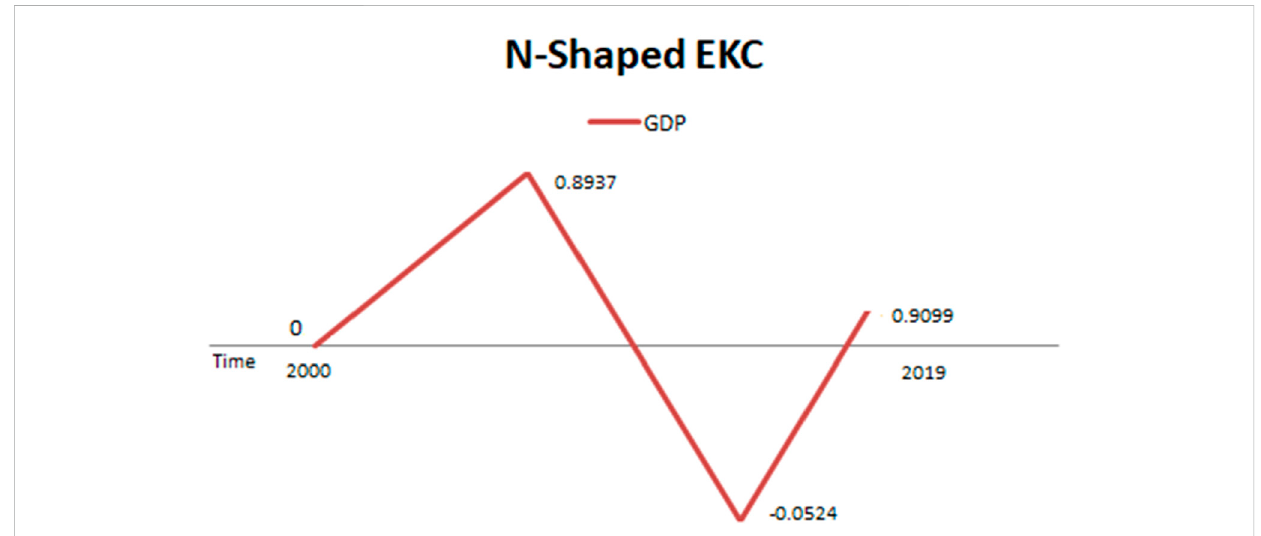
FIGURE 2 N-shaped EKC based on the coef fi cients calculated through the ARDL